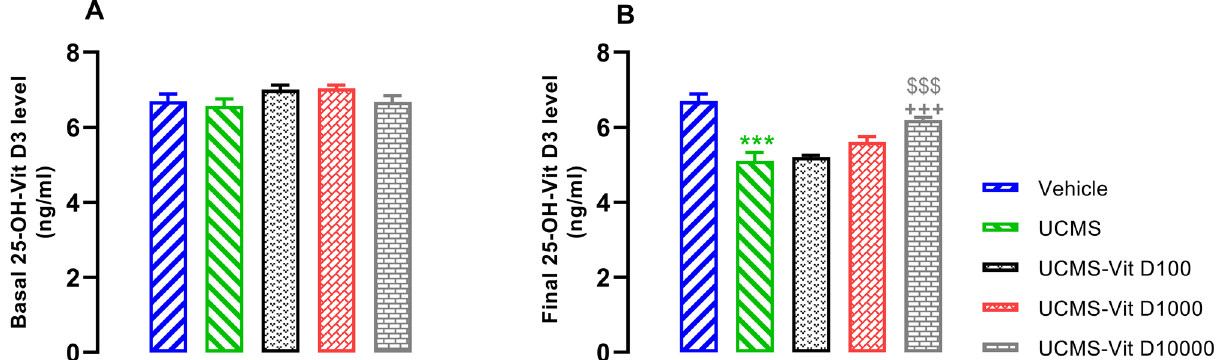
Figure 8. Basal ( A ) and final ( B ) levels of Vit D in UCMS groups. Data are presented as mean ± SEM, n = 10. *** P < 0.001 versus Vehicle group, + + + P < 0.001 versus UCMS group, $$$ P < 0.001 versus UCMS-Vit D100